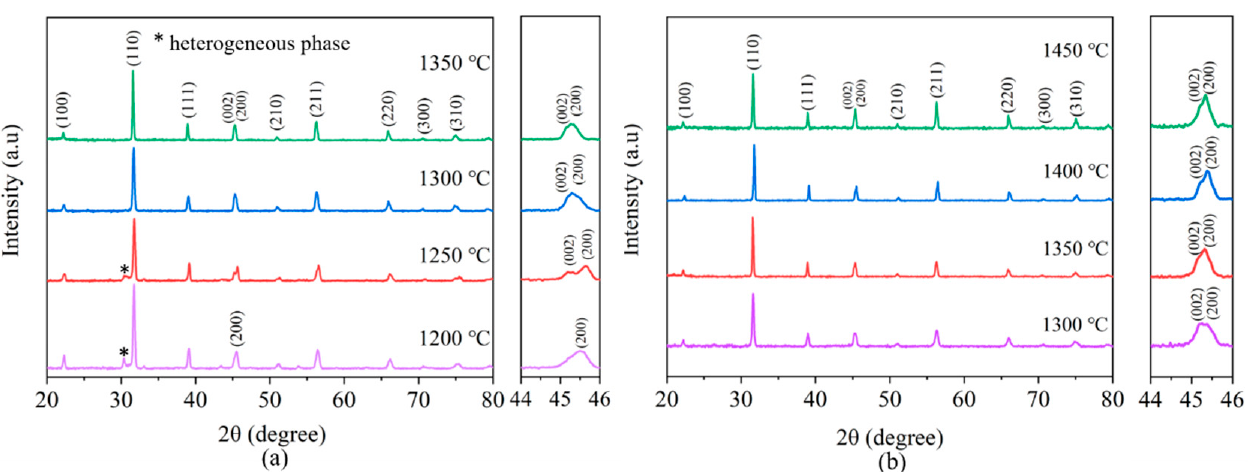
Figure 2. ( a ) XRD patterns of BCZT powders calcined at the different temperatures with the enlarged views of the peaks 2 θ ≈ 44–46 ◦ . ( b ) XRD patterns of porous BCZT piezoelectric ceramics sintered at different temperatures with the enlarged views of the peaks 2 θ ≈ 44–46 ◦ .